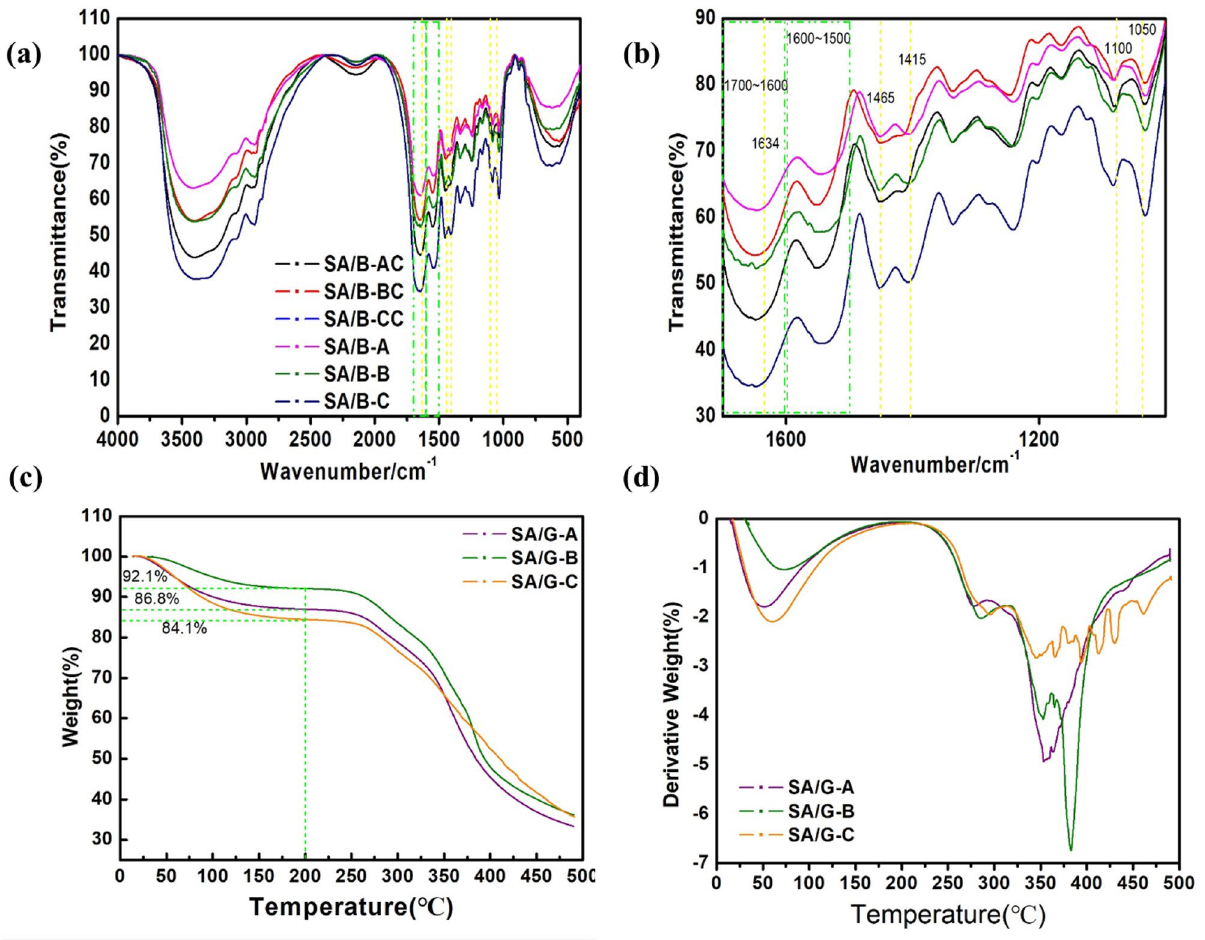
Figure 2. FTIR property and thermal property. ( a , b ) FTIR spectra; ( c ) TGA curves and ( d ) DTG